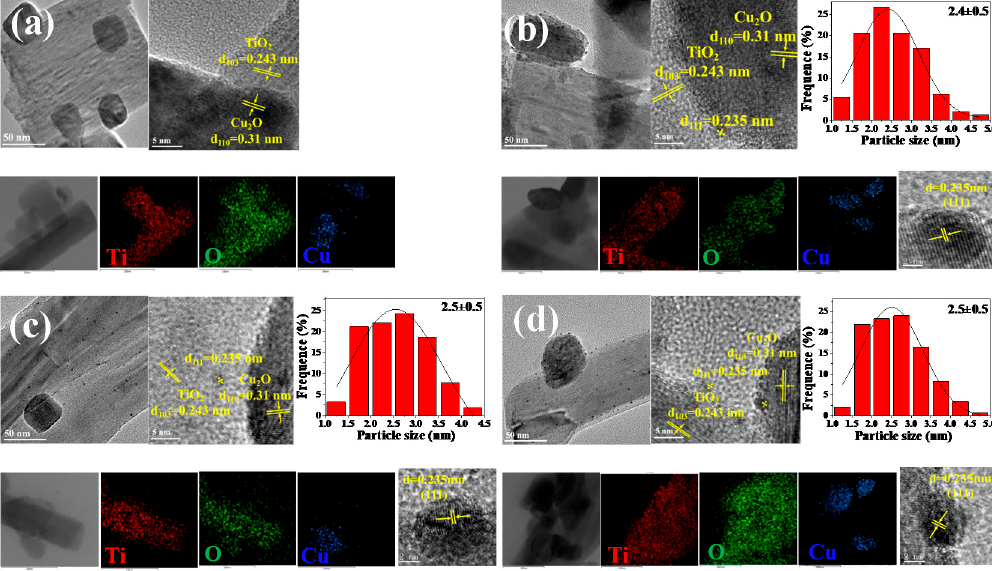
Figure 1. HRTEM images and EDS mapping of ( a ) Cu 2 O / TiO 2 ( b ) Au@Cu 2 O / TiO 2 , ( c ) Au@TiO 2 / Cu 2 O, ( d ) Au@TiO 2 / Cu 2 O@Au, with histogram of Au NPs size distribution of each sample (100 particles are counted).